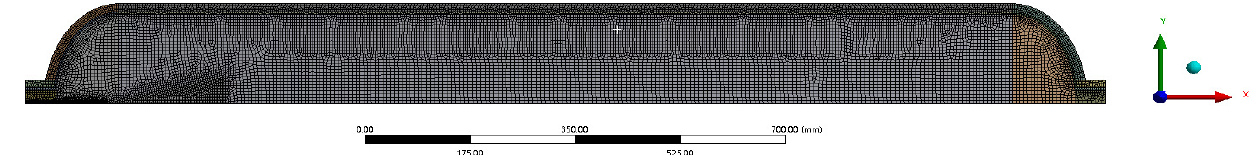
Figure 1. 2D axisymmetric meshes for the 145 L hydrogen